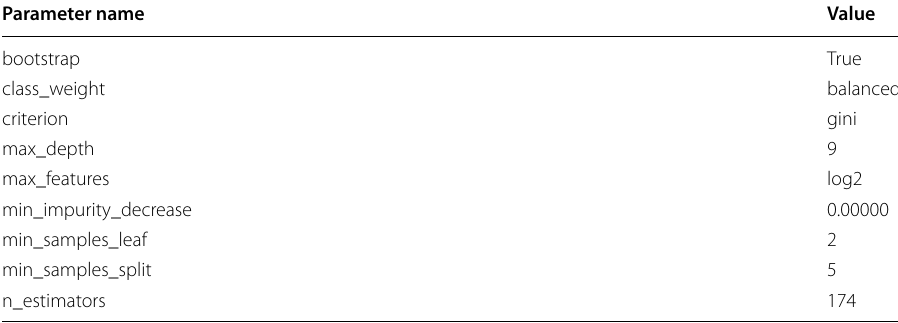
Table 75 Modes of RF tuned hyperparameter values for experiments with the information theft